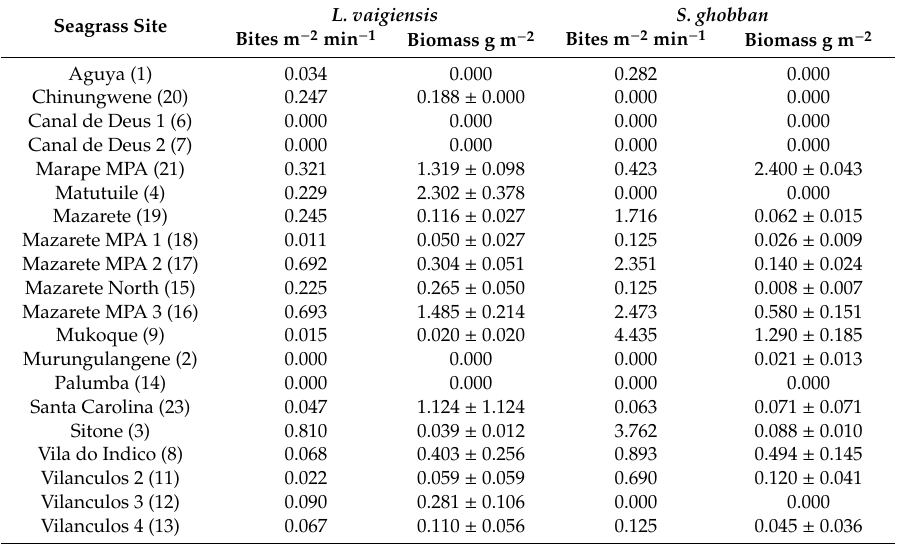
Table 1. Bite rates per m 2 per minute and hour in the seagrass sites. Numbers in parentheses refers to the numbers in Figure 1.